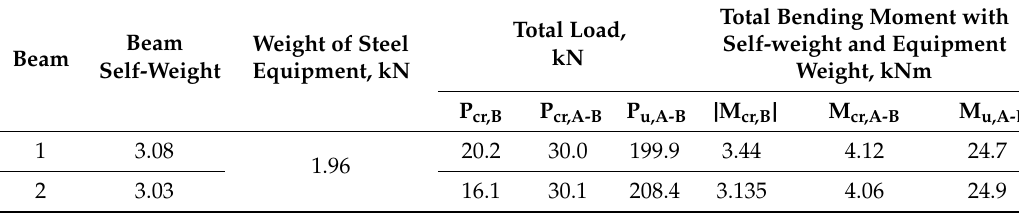
Table 1. Test results for beams (with self-weight and equipment